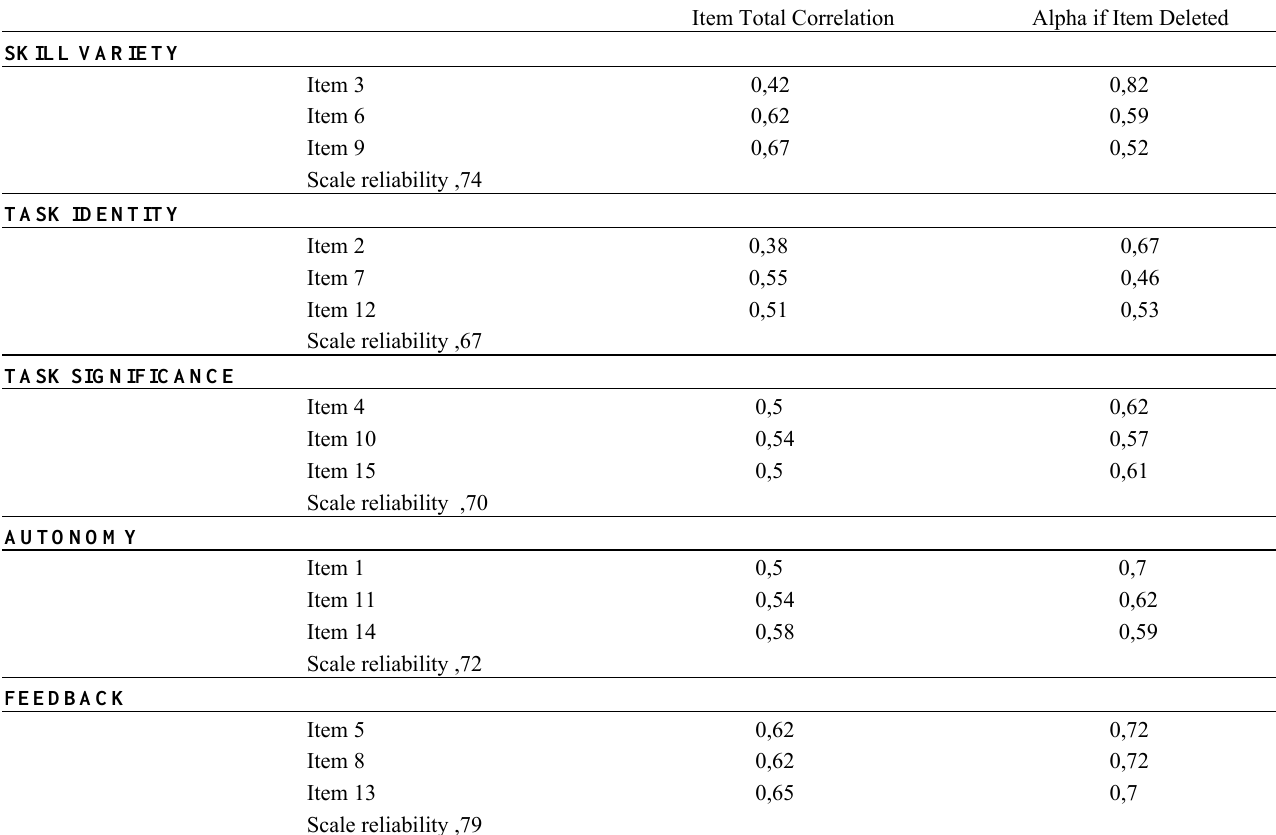
Table 4 : Item analysis of the revised JDS